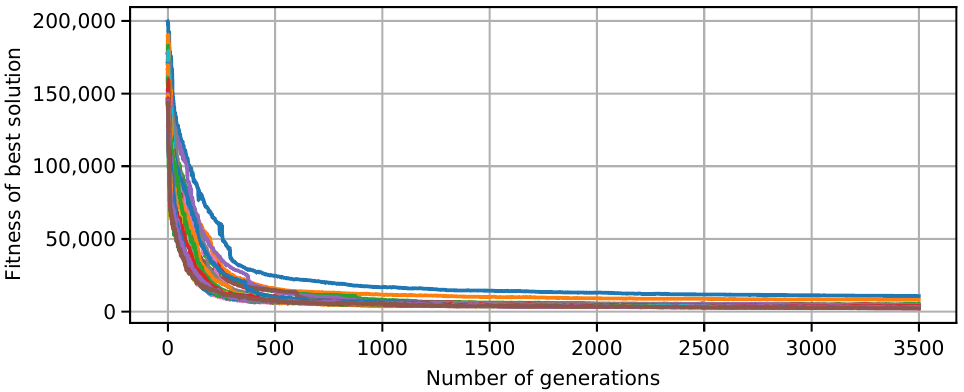
Figure 8. Convergence of the fitness of the best solutions discovered for each